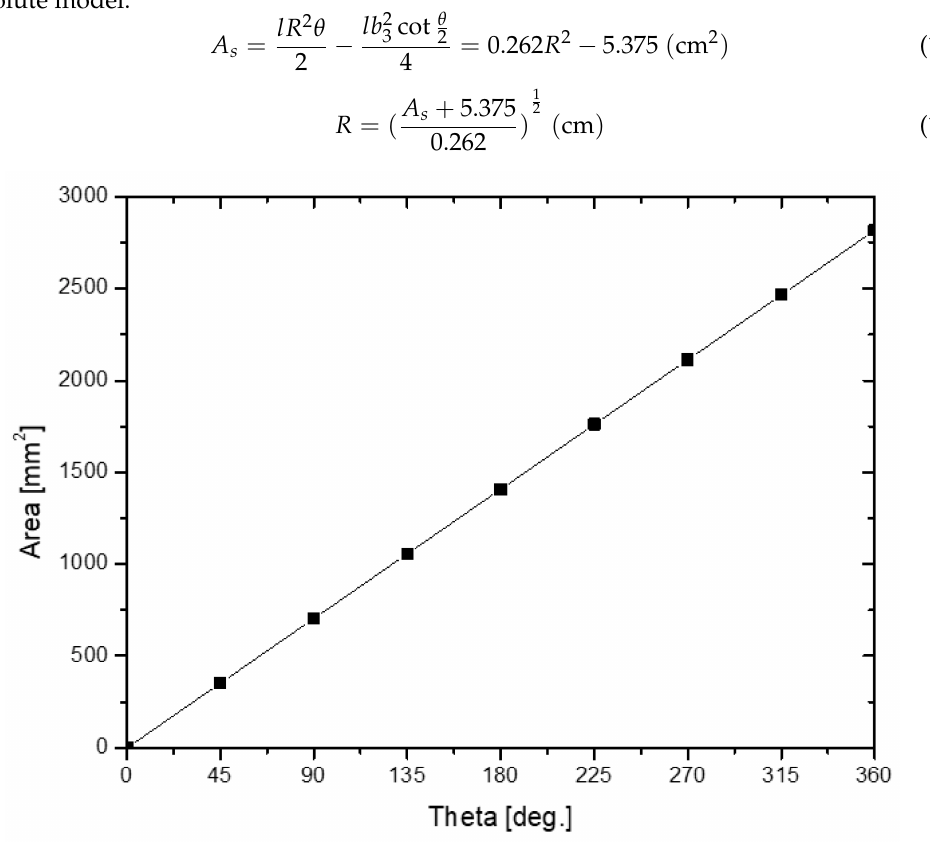
Figure 3. Area distribution of the volute